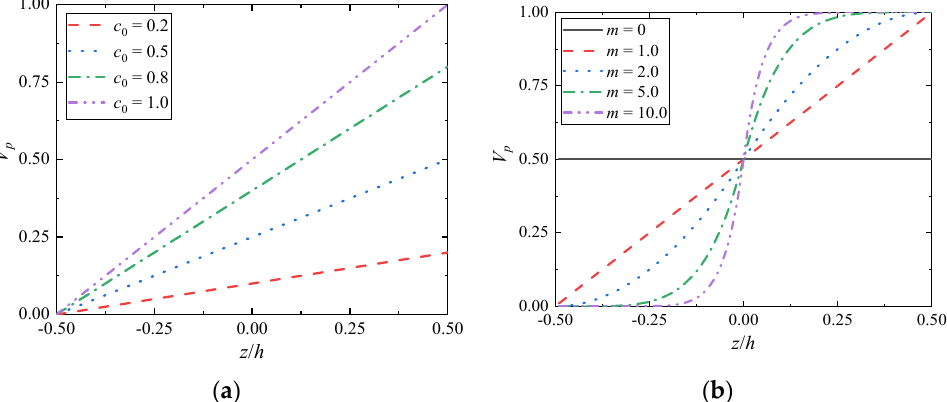
Figure 1. Variation of volume fraction V p vs. FGMs structure: ( a ) the variational material component ratio coefficients c 0 ( m = 1.0); ( b ) the variational gradient indexes m ( c 0 = 1.0).